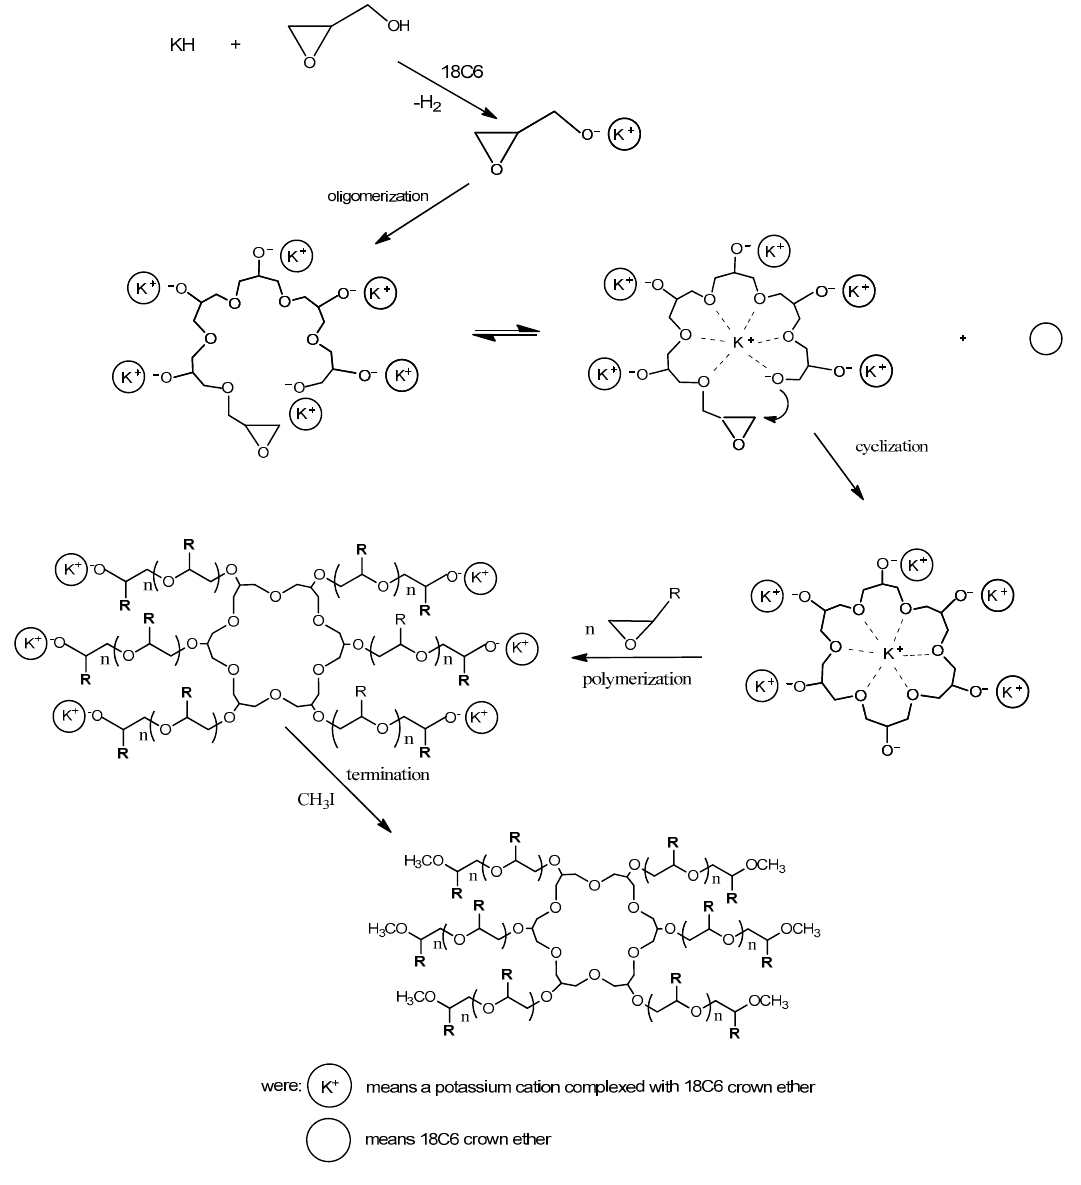
Figure 1. The reaction obtaining 6 arm star-shaped polymers.